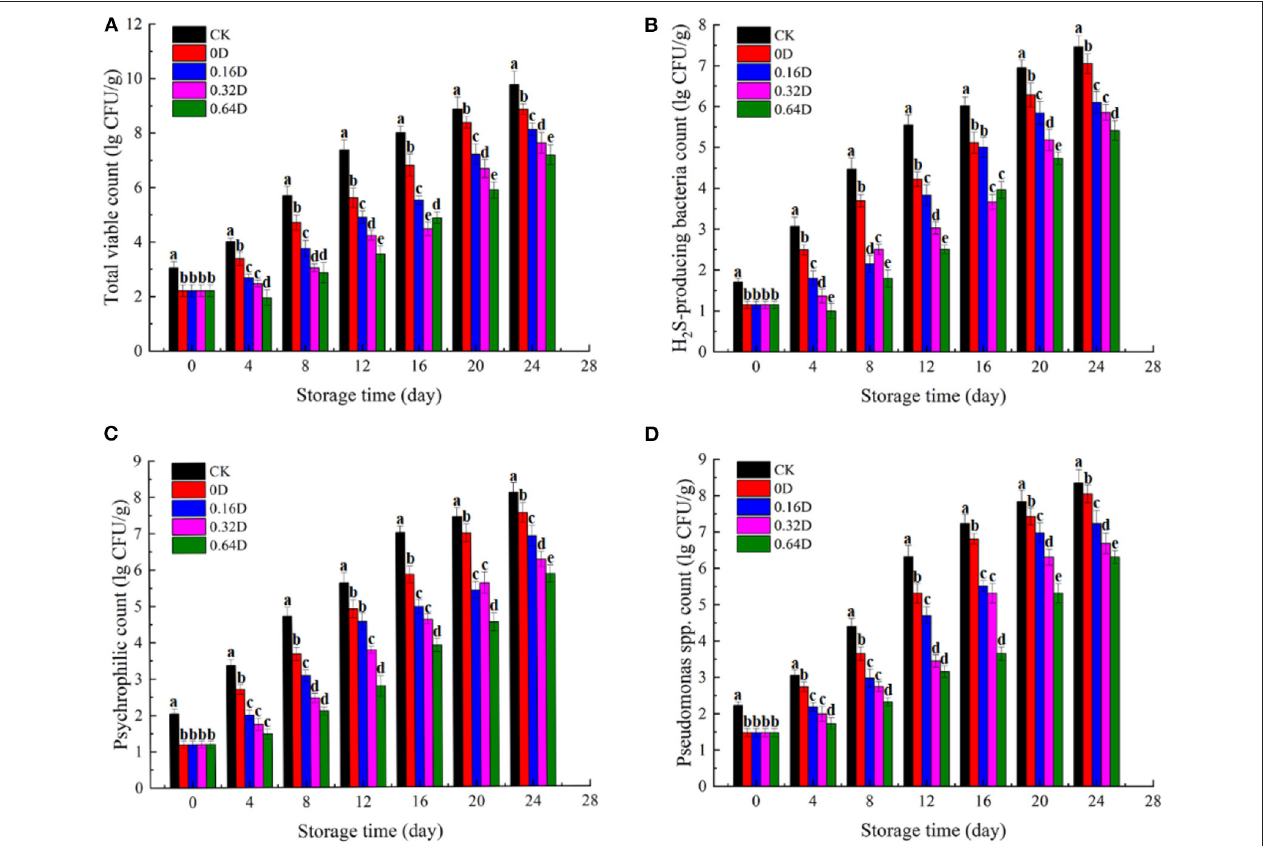
FIGURE 1 | Changes in (A) total viable counts, (B) H 2 S-producing bacteria counts, (C) psychrophilic counts, and (D) Pseudomonas spp. counts of turbot samples during refrigerated storage [CK, washed with deionized water; 0D, immersed in weakly acidic electrolytic water (WAEW) for 10min, followed by a coating with a locust bean gum–sodium alginate (LBG-SA)-active coating; 0.16D, immersed in WAEW for 10min, followed by a coating with an LBG-SA coating with 0.16 g/L daphnetin; 0.32D, immersed in WAEW for 10min, followed by a coating with an LBG-SA coating with 0.32 g/L daphnetin; 0.64D: immersed in WAEW for 10min, followed by a coating with an LBG-SA coating with 0.64 g/L